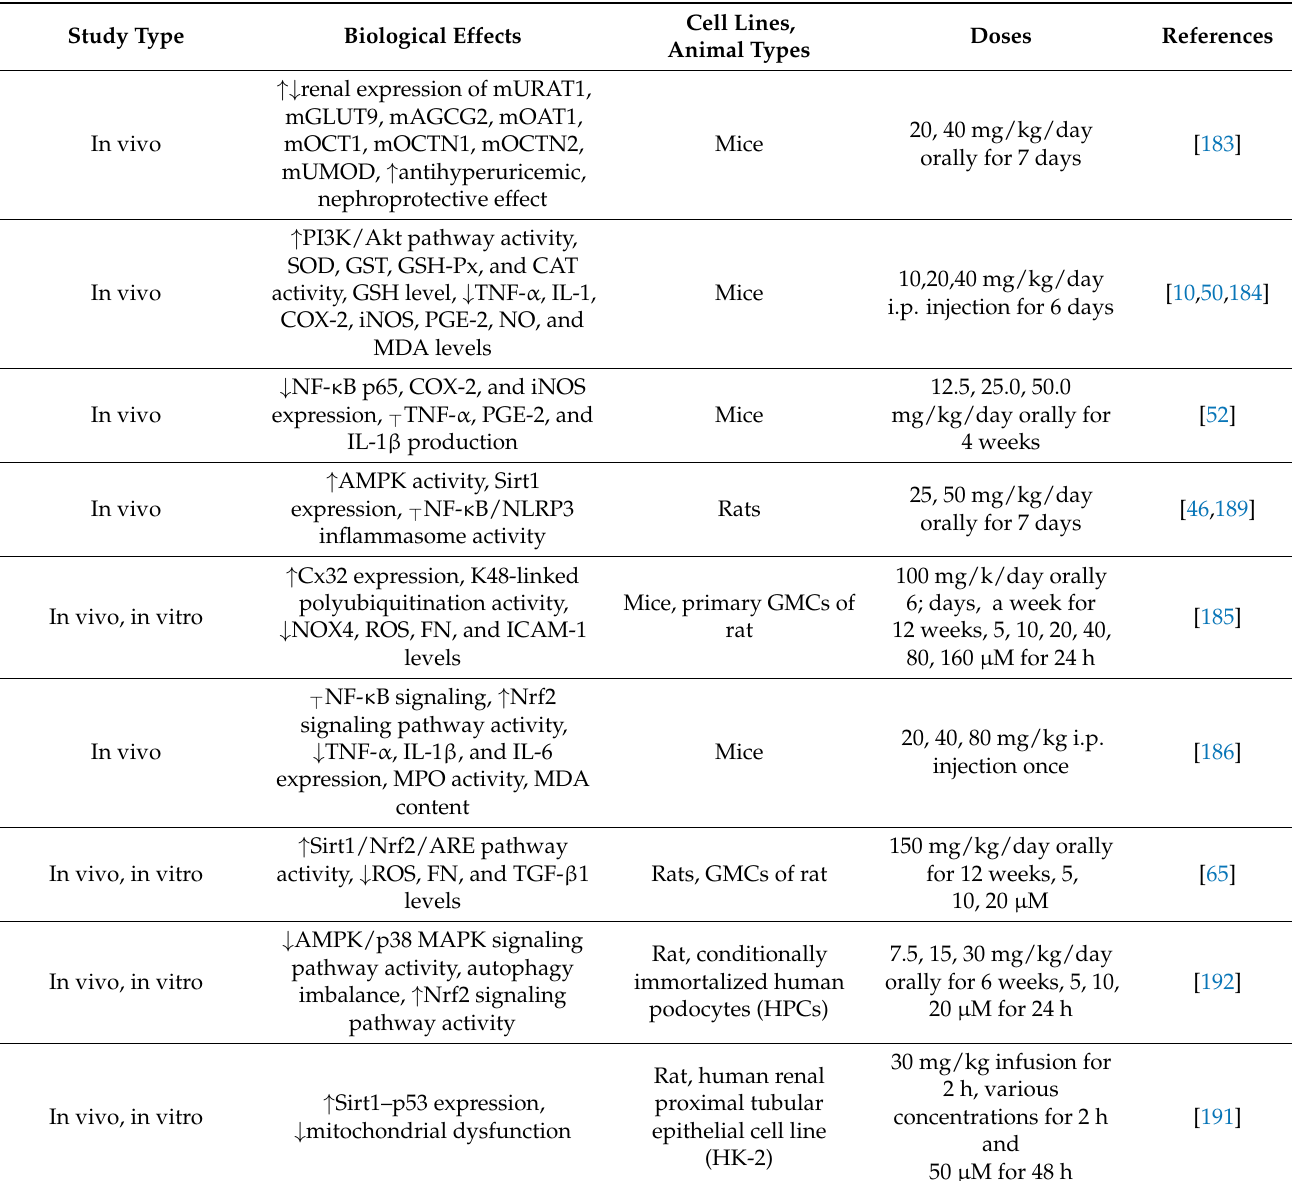
Table 5. Effect of polydatin on the renal